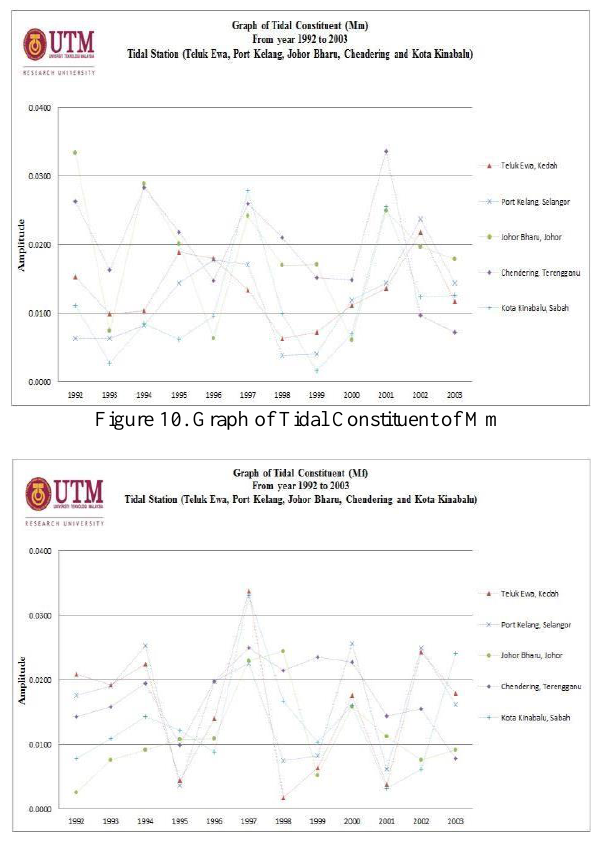
Figure 11. Graph of Tidal Constituent for Mf Figure 14. Figure of Indian Spring Low Water (ISLW) Based on Figure 14, it show that the value of Indian Spring Low Water (ISLW) for every station along year 1992 to 2003. It shows that there is big changing of value ISLW for station at Teluk Ewa, Kedah and Port Kelang, Selangor which is the ISLW decrease in year Teluk Ewa and Port Kelang due to the different position of the station. Department of Surveying and Mapping Malaysia (JUPEM) refer to this value of ISLW to predict the tide. There is a big change in year 1997 which can affect the data prediction made by Department of